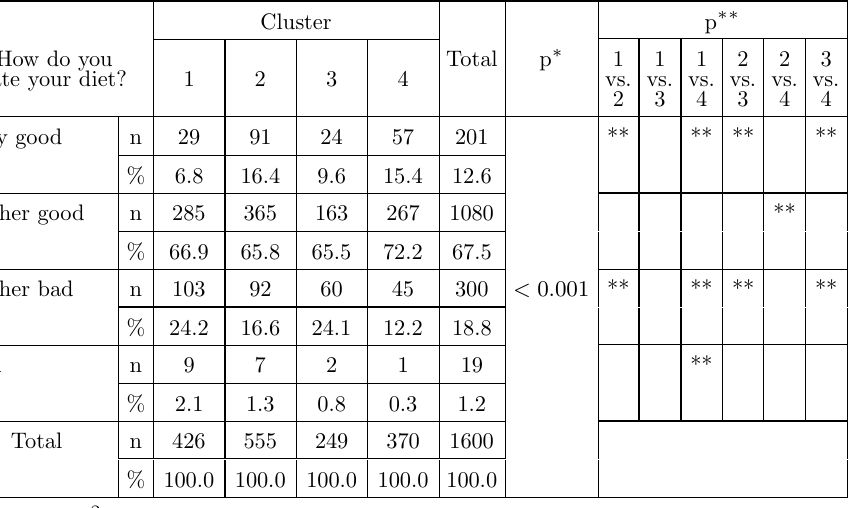
Test for two proportions with a Bonferroni correction for multiple comparisons, p < 0 .